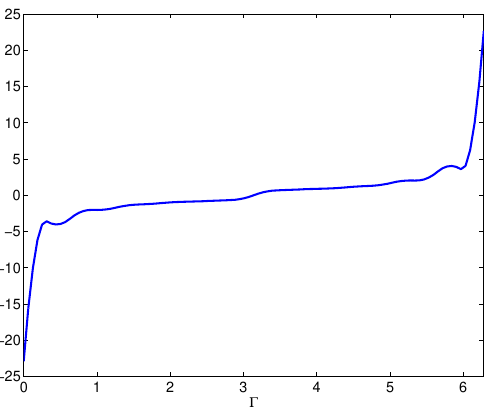
Figure 23. Density ˜ ψ ( x ,60 ) , obtained fixing quadratic B-spline